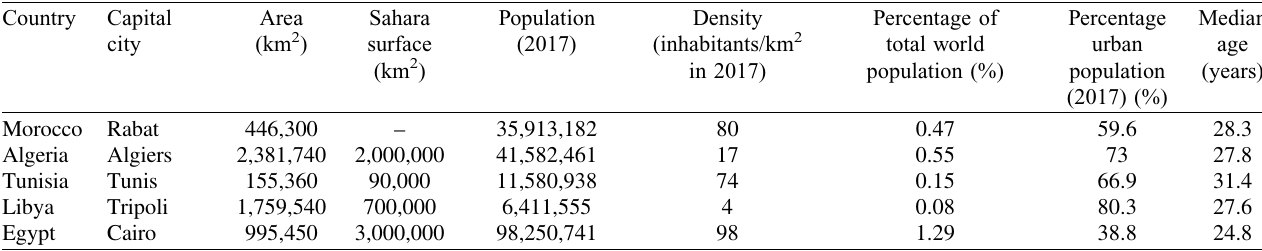
Table 1. Characteristics of North African countries.